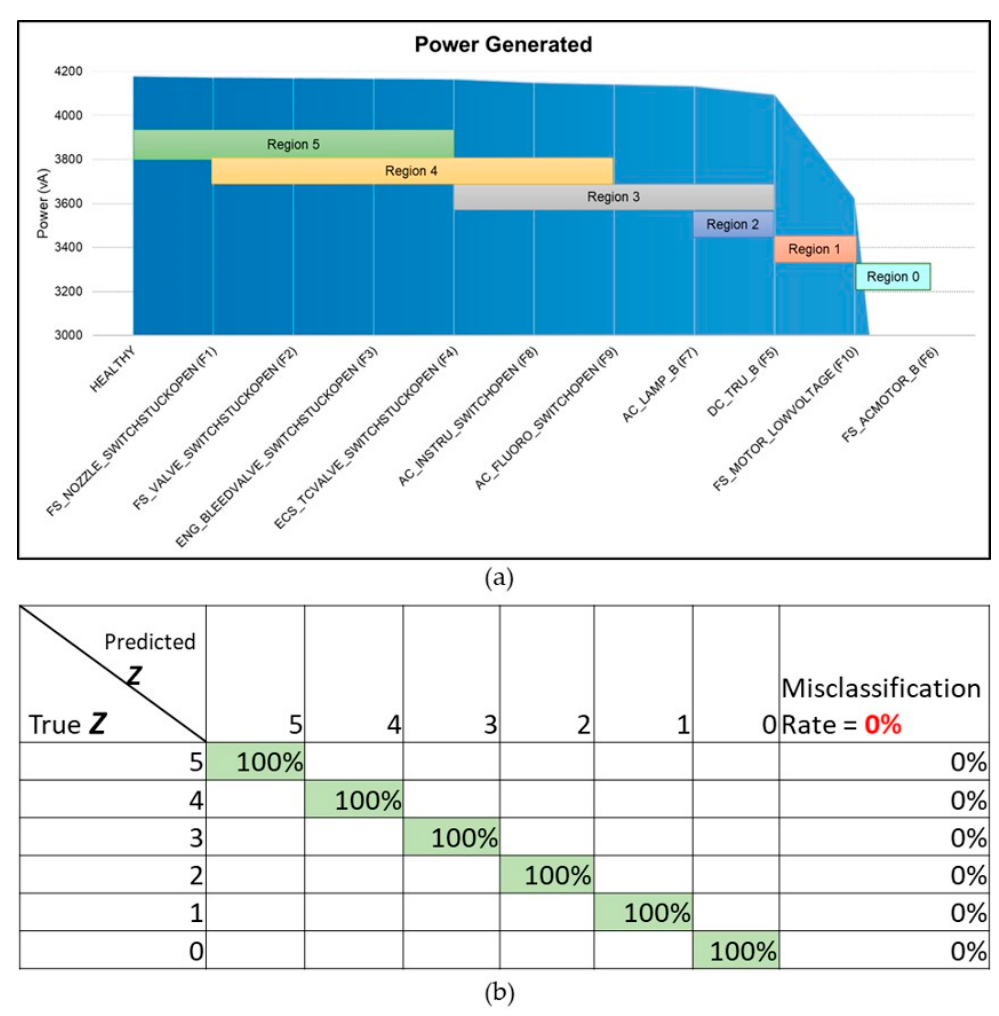
Figure 12. ( a ) Fuzzy boundaries representing healthy and faulty scenarios based on the power generated. ( b ) Confusion matrix for method 2 ANFIS rank processing with fuzzy boundaries . Table 3. Diagnostic matrix for faults vs. tests .